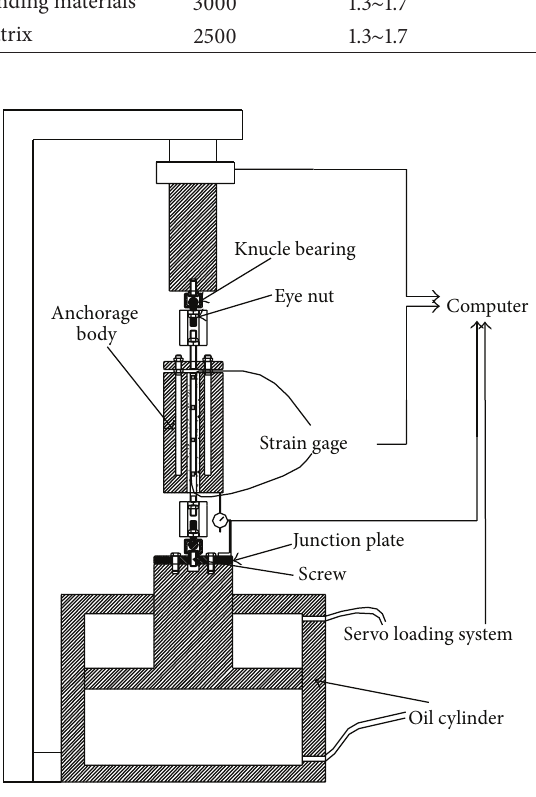
Figure 3: Pull-out test apparatus of anchorage